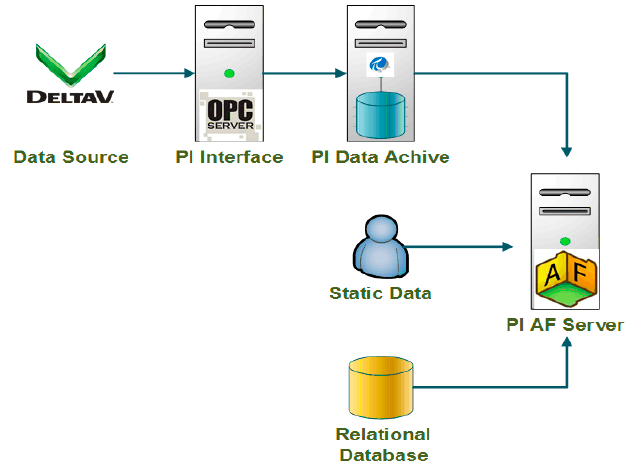
Figure 10. Structure and data flow of Process Information (PI) system.